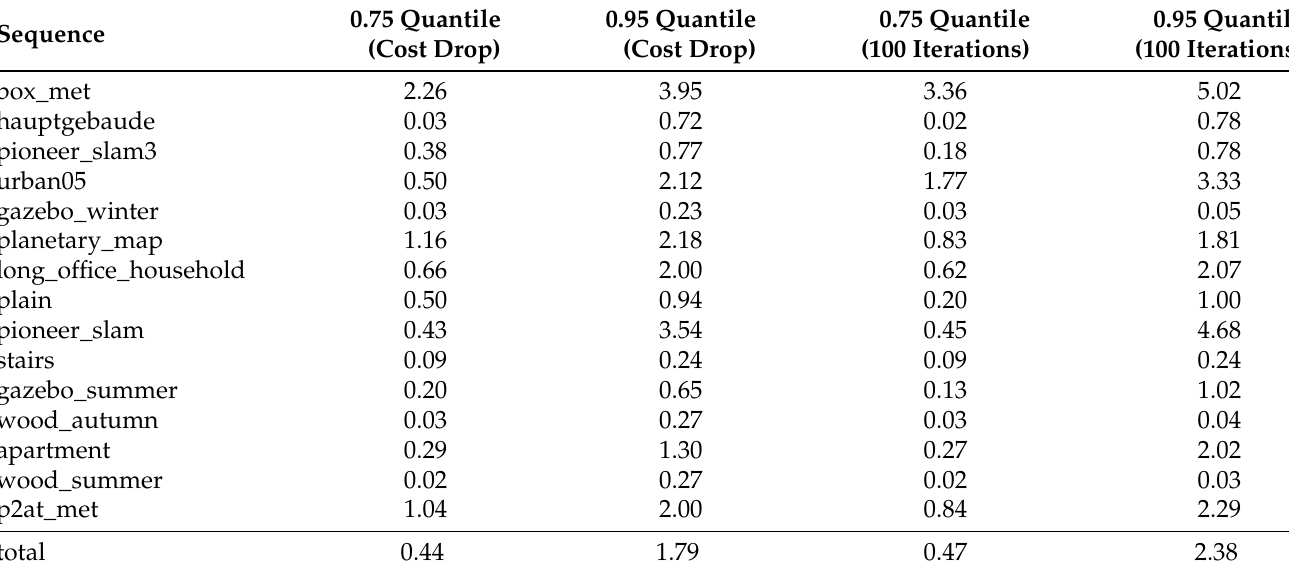
Table 4. The 0.75 and 0.95 quantiles of the results of PPCR on a comprehensive benchmark [6] with two different termination criterion (100 iterations and the cost